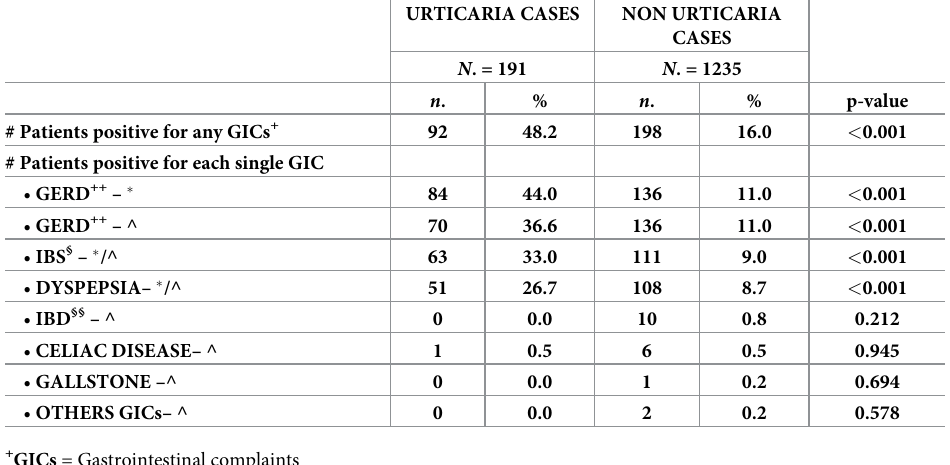
Table 2. Prevalence of gastrointestinal complaints by the presence or absence of urticaria in all 1426 consecutive patients.